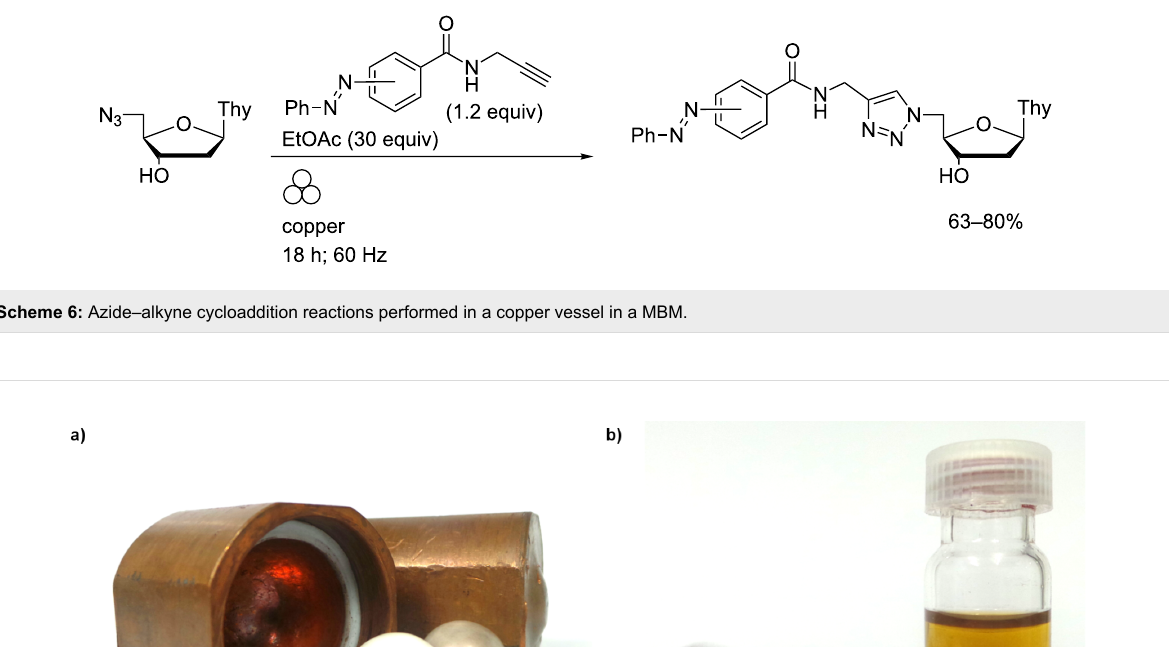
nucleoside derivatives typical of solution-phase reactions using such substrates. More variable yields were obtained using potassium seleno- cyanate which required grinding in the presence of DMF to promote the reaction with adenosine or thymidine derivatives (Scheme 8). No reaction of 5 ′ -chloro-5 ′ -deoxyadenosine was